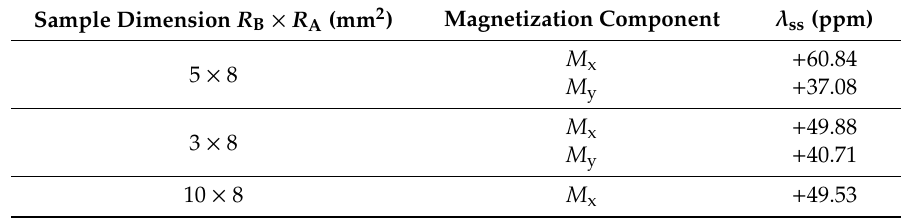
Table 4. Local surface saturation magnetostrictive coe ffi cient λ ss of FeCoB ribbon calculated in longitudinal MOKE configurations sensitive to magnetization components M x or M y